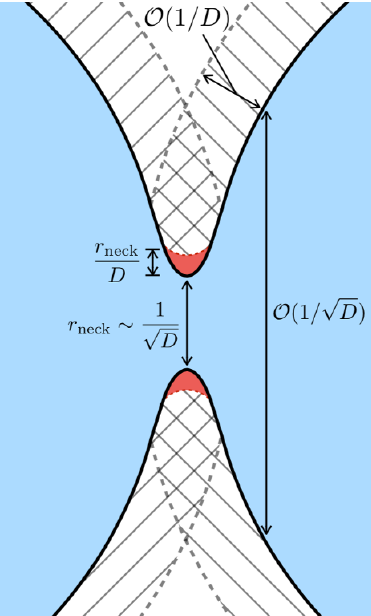
Figure 5 . The di(cid:11)erent regions of the neck in the fused conifold, and their sizes. Blue: non- uniform black string. Hatched: near-horizon region, of size O (1 =D ). Red: near-neck region, of size (cid:0) (cid:1) O 1 =D 3 = 2 . The latter is the region resolved in section